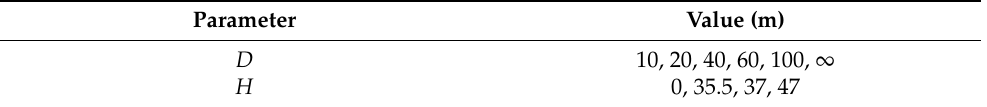
Table 3. Values for D and H in the model.